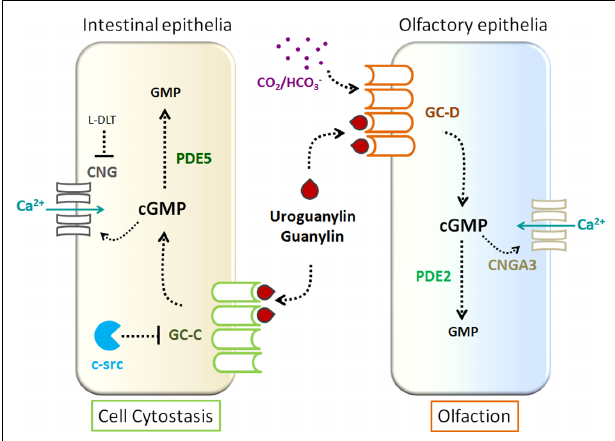
FIGURE 1 | Non-canonical signaling by the guanylin and uroguanylin family of peptide hormones. Binding of guanylin and uroguanylin to GC-C in the intestinal epithelial cell results in an increase in cGMP levels. Intracellular cGMP levels are reduced by the action of PDE5, which cleaves cGMP to form 5 (cid:2) -GMP. Cyclic GMP can act directly on CNG channels to increase cellular Ca 2 + levels, resulting in colon cell cytostasis.This process is attenuated by the action of cis -l-diltiazem (L-DLT), a CNG channel inhibitor. The tyrosine kinase c-src which is frequently found to be activated in colorectal carcinomas, phosphorylates and inhibits GC-C activity, thereby reducing the anti-tumorigenic effects induced by guanylin/uroguanylin/ST peptides. In olfactory epithelia, uroguanylin/guanylin is recognized by GC-D expressed in a sub-set of neurons and evoke action potentials.These neurons also fire in response to CO 2 / HCO − . Hydrolysis of cGMP in these 3 cells is thought to be mediated by PDE2.The renal effects of uroguanylin have been detailed in an earlier review, and are not shown in this figure (Sindic and Schlatter,